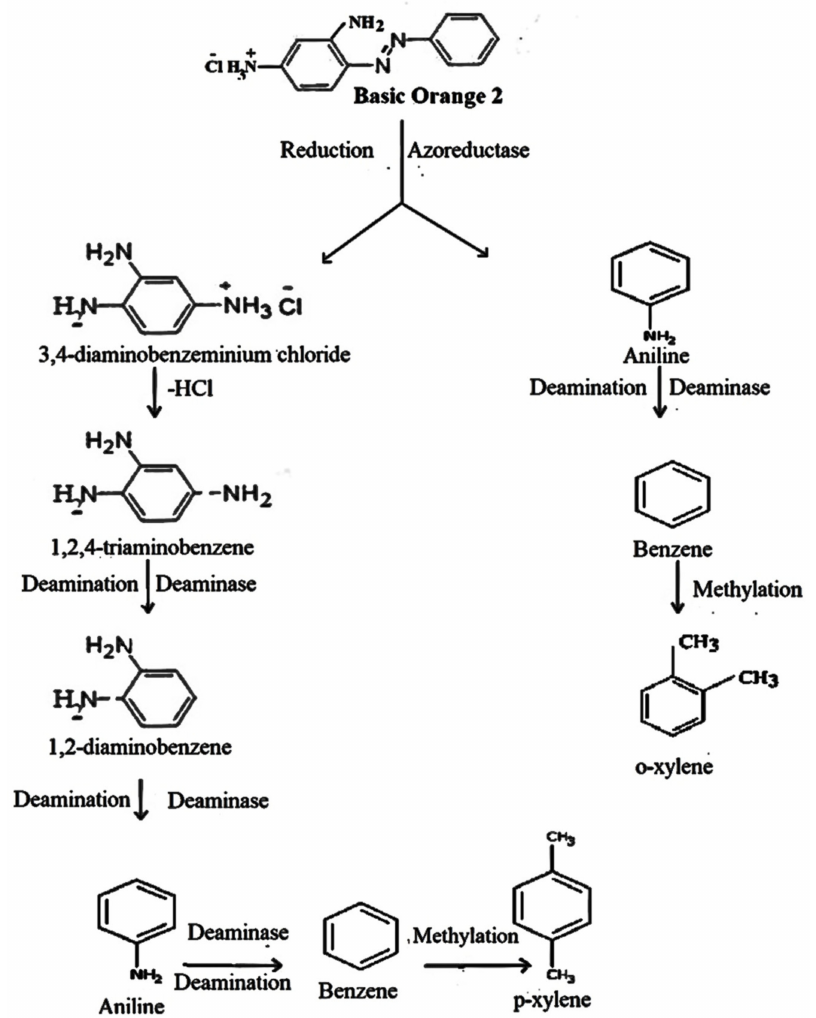
Figure 16. Proposed mechanism for the degradation of Basic Orange 2 by Escherichia coli